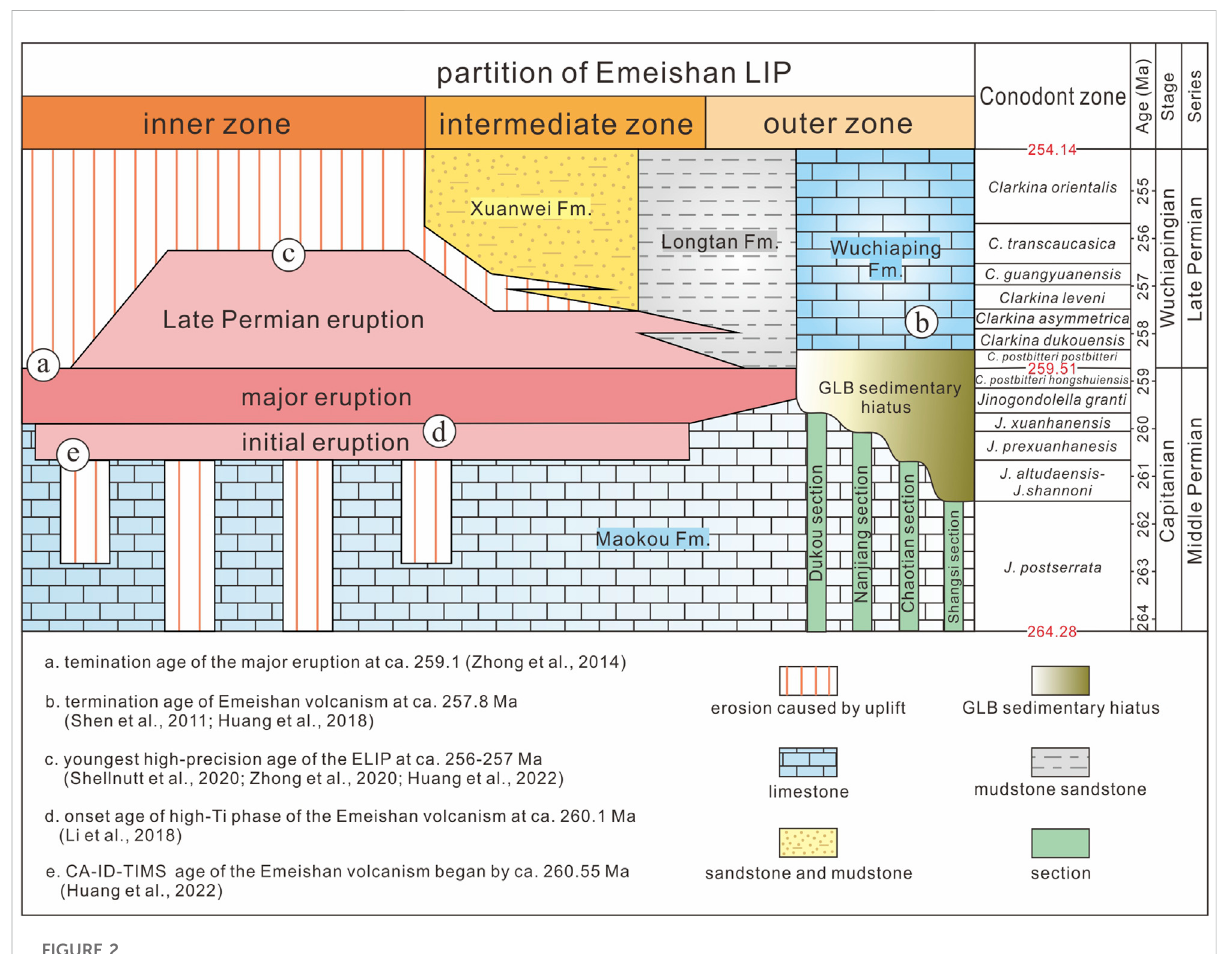
FIGURE 2 GLB lithostratigraphic sedimentary sequence (Wang et al., 2020), spatial-temporal distribution of the Emeishan LIP (Shen et al., 2011; Zhong et al., 2014, 2020; Li D. D. et al., 2018; Huang et al., 2018, 2022; Shellnutt et al., 2020), and GLB biostratigraphic correlation (Mei et al., 1994a; 1994b; Mei, 1995; Lai et al., 2008). Chronostratigraphic scale is according to Shen et al.